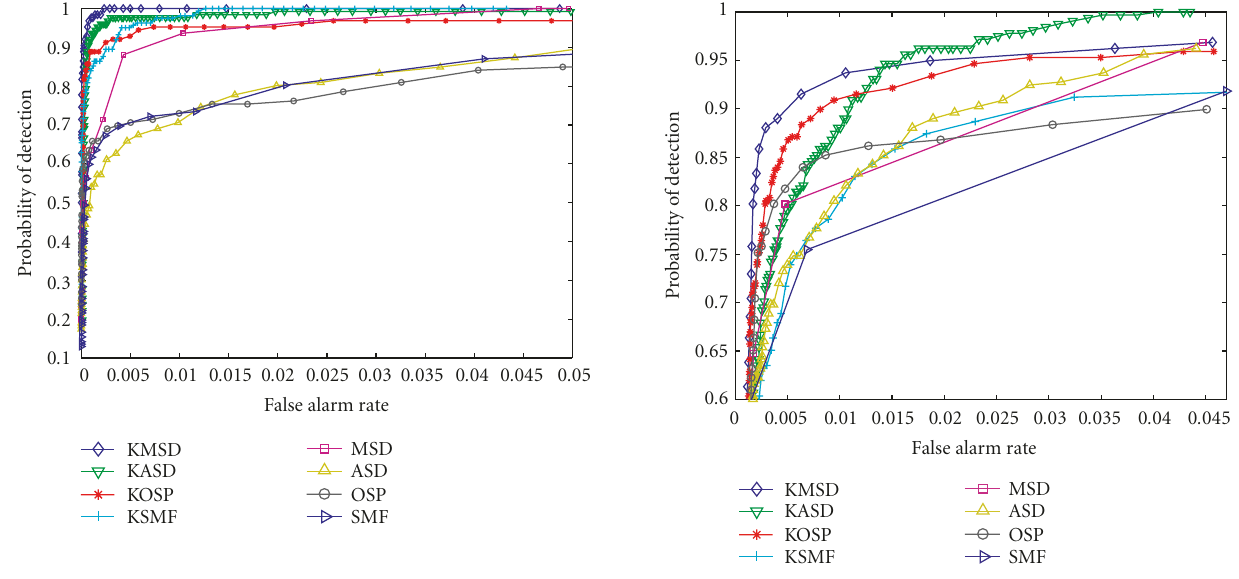
Figure 6: ROC curves obtained by conventional detectors and the corresponding kernel versions for the DR-II image.